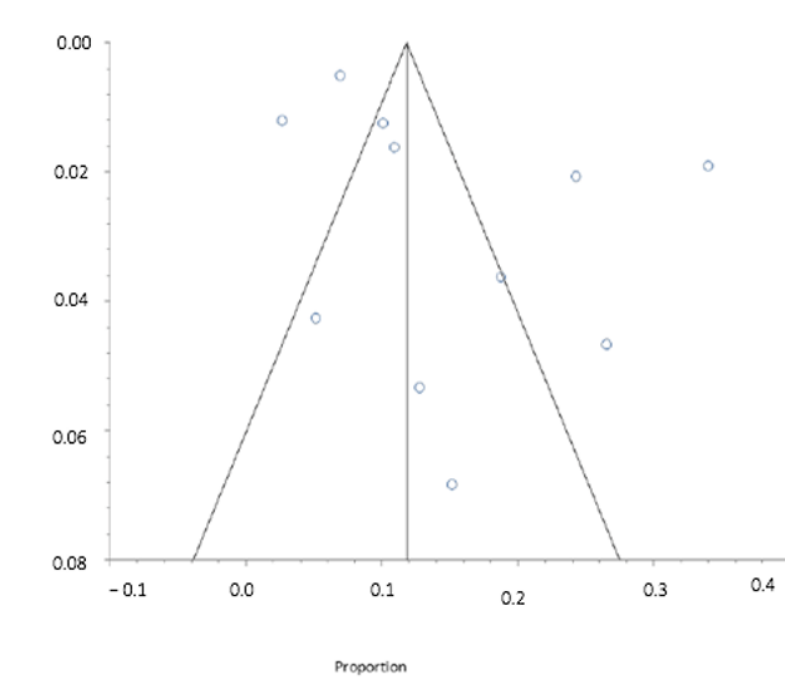
Figure 2. Funnel plot. The graphical equivalent of publication bias tests of Table 2. These small circle are the graphical representation of the final studies selected (n = 11).